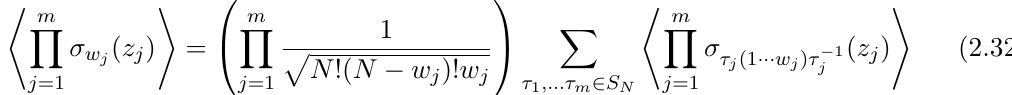
( z 1 ) (cid:27) g ( z 2 ) (cid:1) (cid:1) (cid:1) (cid:27) g ( z m ) i 1 2 m